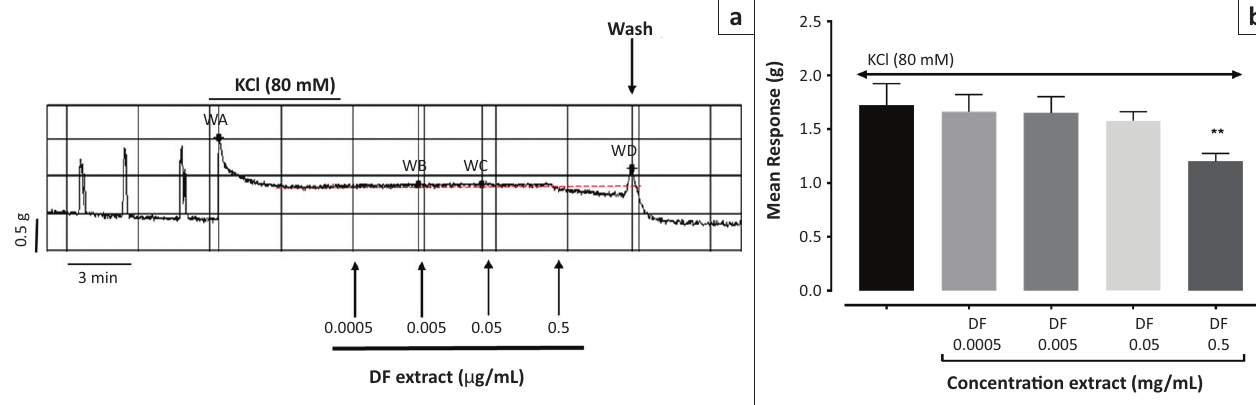
FIGURE 5: Effect of D. filix-mas (DF) on high KCl-induced (80 mM) uterine contraction. (a) Original recording of DF on high KCl-induced uterine contraction (80 mM). (b) Bar graphs showing the effect of DF (0.0005–0.5 mg/mL) on KCl-induced contraction. A significant depression ( p < 0.01) was observed at the highest concentration of DF used in this study of ** p < 0.01; n = 5